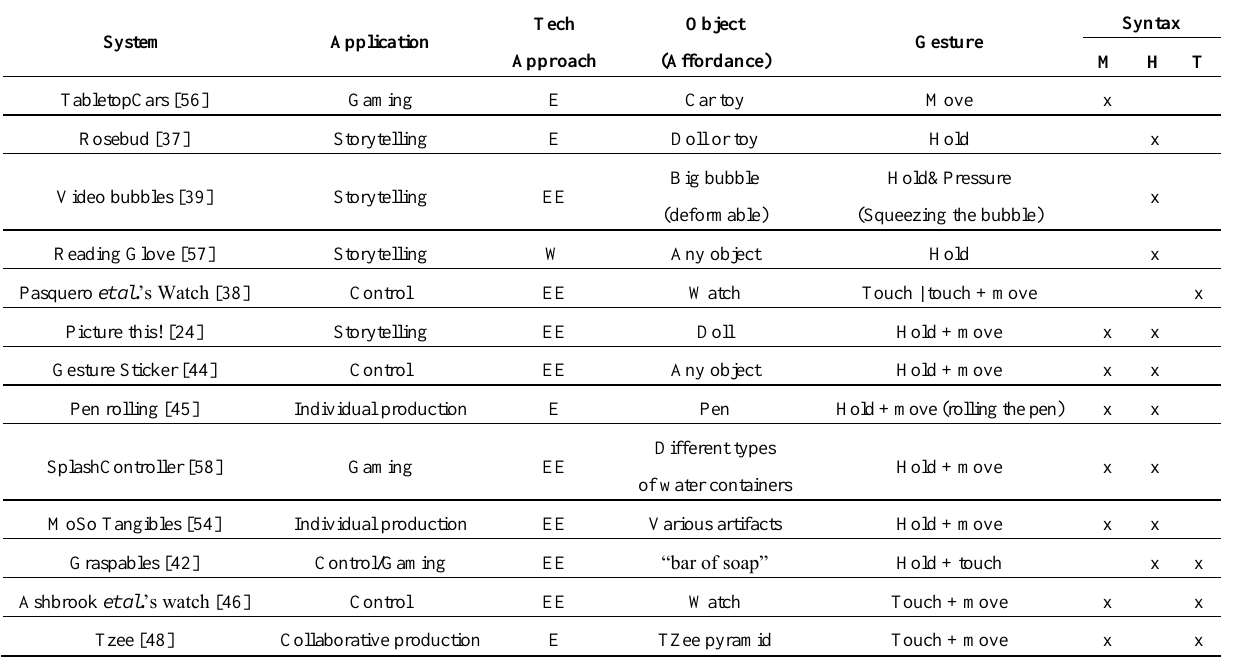
Table 1. Classification of TGI systems. EE = Embedded and Embodied, W = Wearable, E =